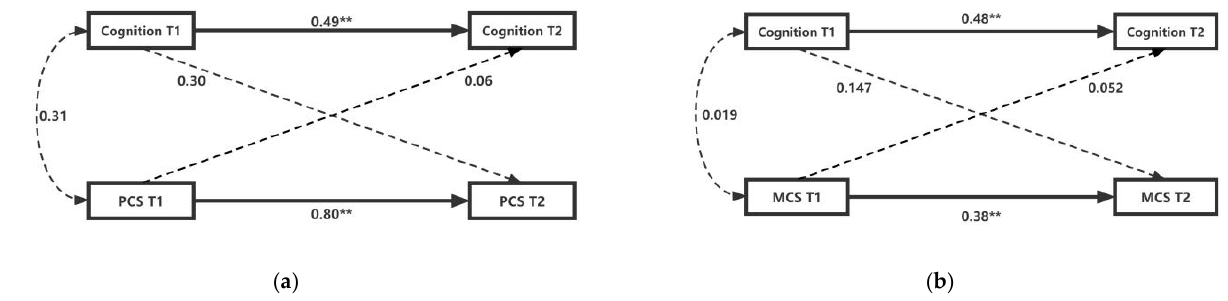
Figure 3. Cross-lag Model of Cognitive Function and HRQoL (digital usage behavior). ( a ) Model 3: the cross-lag relationship between cognitive function and PCS scores; ( b ) Model 4: the cross-lag relationship between cognitive function and MCS scores. PCS, physical component summary; MCS, mental component summary. ** denotes a statistically significant path coefficient p < 0.001.